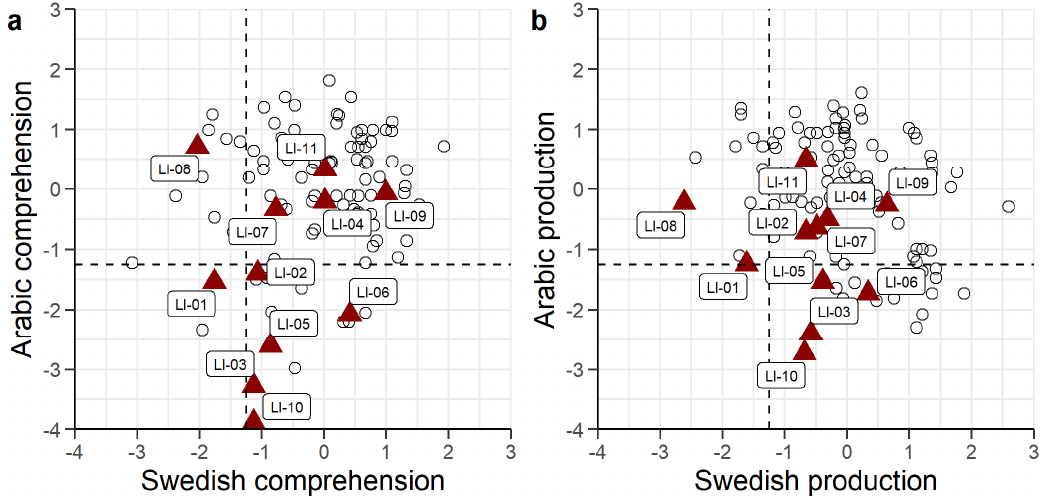
Figure 3. Scatterplots showing age-adjusted z-scores of ( a ) Arabic and Swedish vocabulary compre- hension and ( b ) Arabic and Swedish vocabulary production of the children in the DLD sample (tri- angles and labels) compared to the children in the TD sample (circles). Dashed lines at − 1.25.